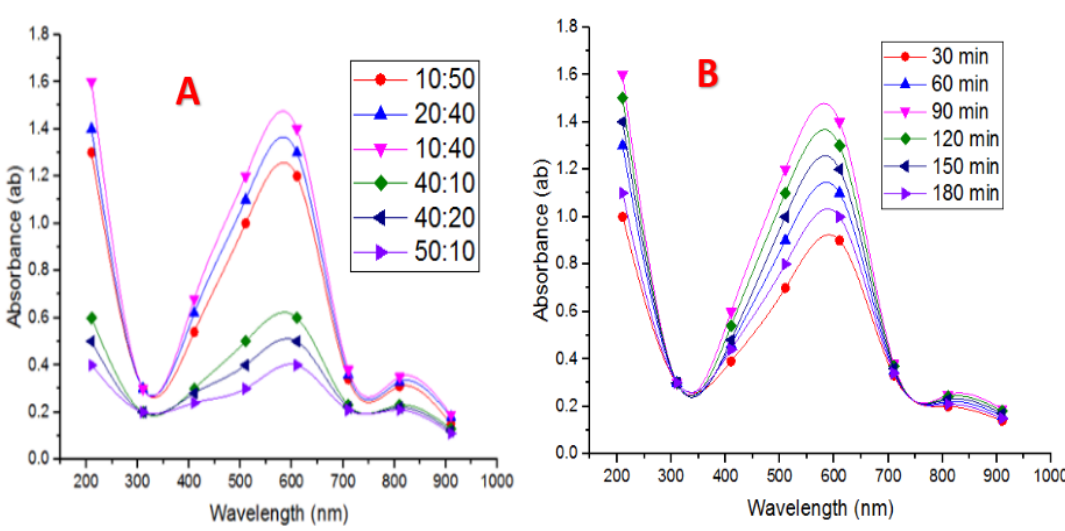
Figure 4. ( A ) UV–Vis spectra of mixing relation of culture supernatant and CuSO 4 ·5H 2 O. ( B ) UV–Vis spectra of incubation times used during CuNPs biofabrication by P. fluorescens MAL2.